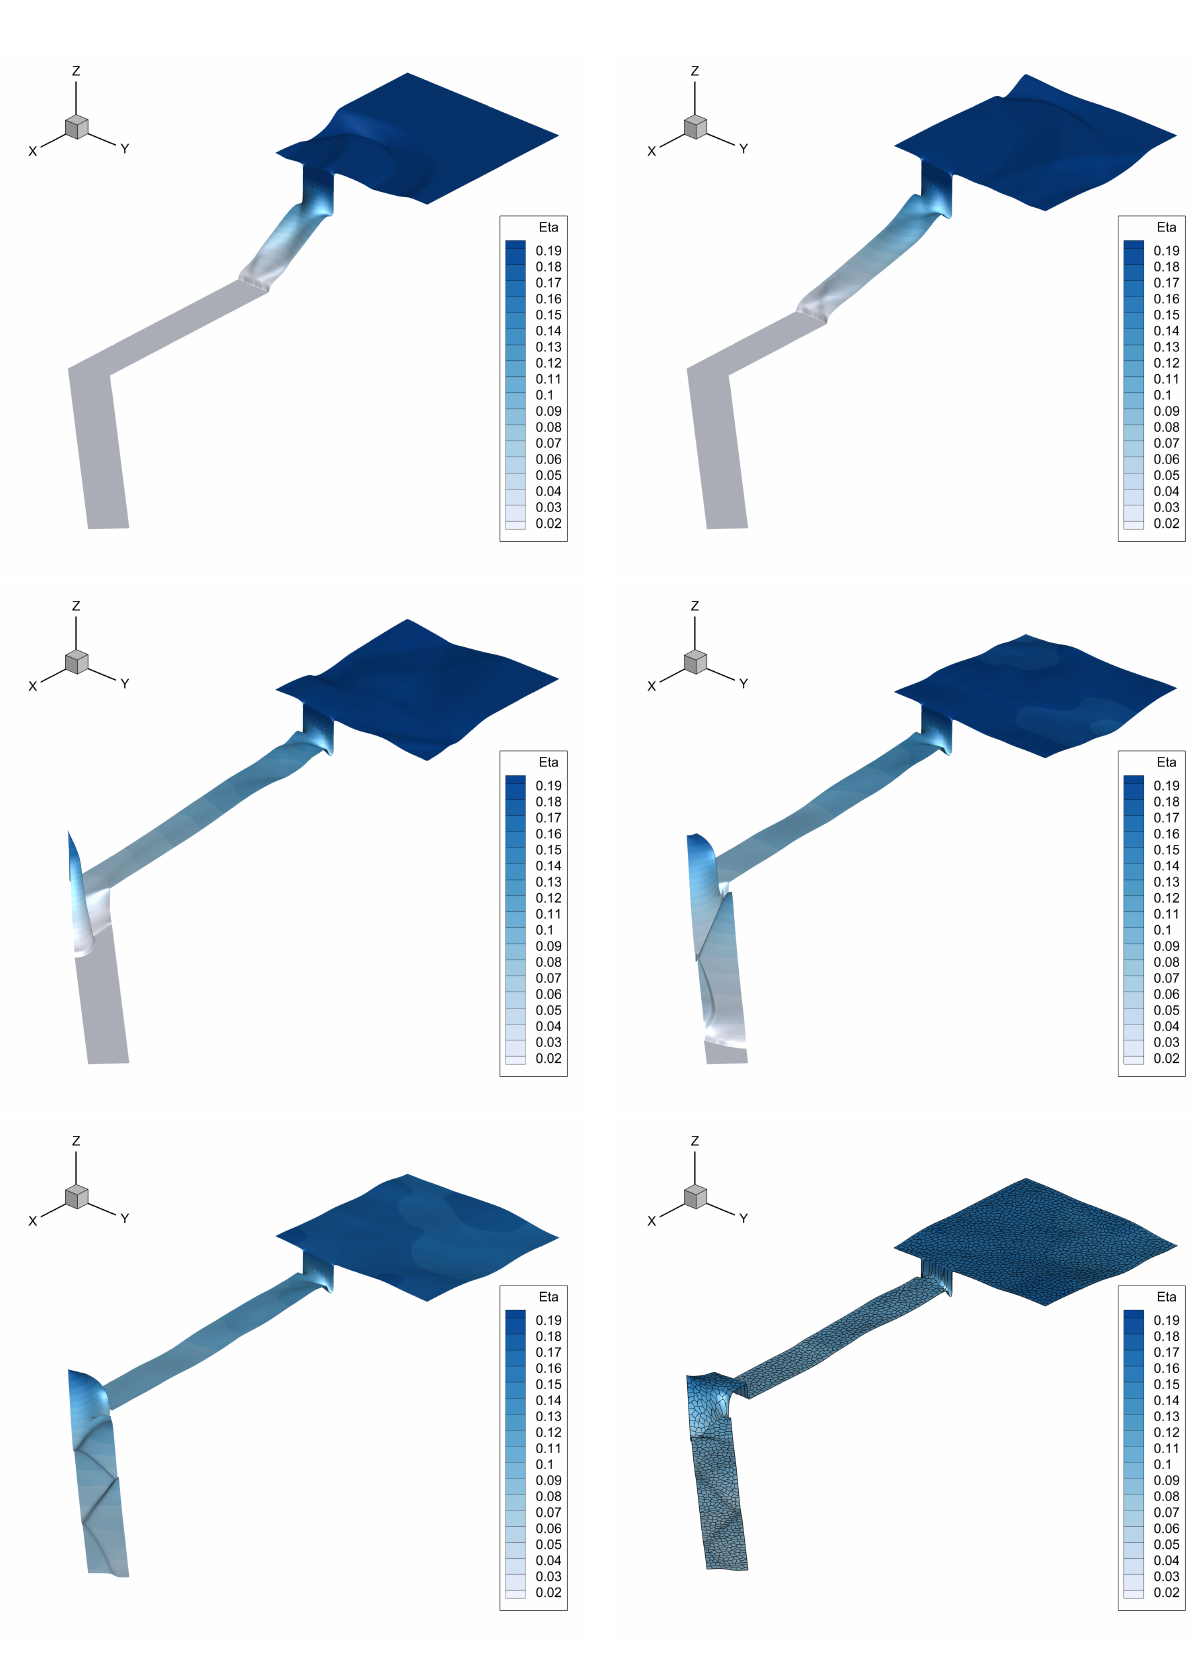
Figure 26. Free surface elevation of the CADAM test case obtained at times t figure also depicts the MPI partition obtained using METIS and used to run the test on 2400 CPU cores of SuperMUC- NG